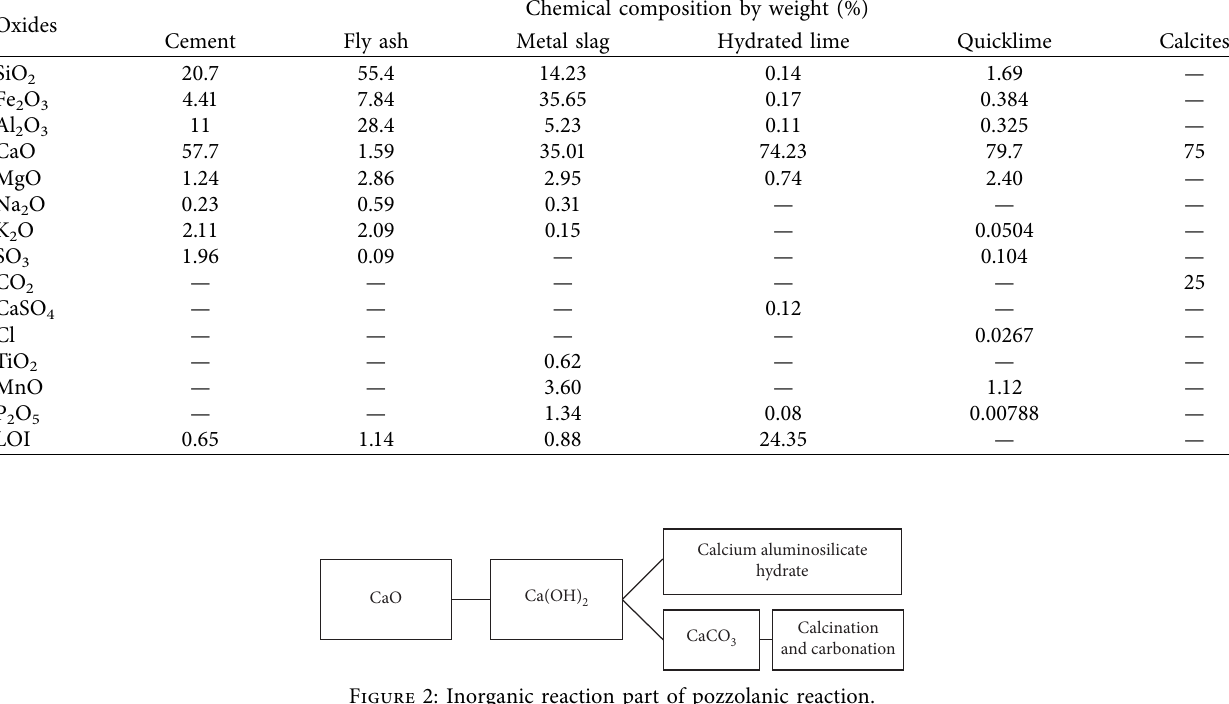
Table 6: Chemical oxide composition of selected inorganic clayey soil binders [16, 18, 25–27].